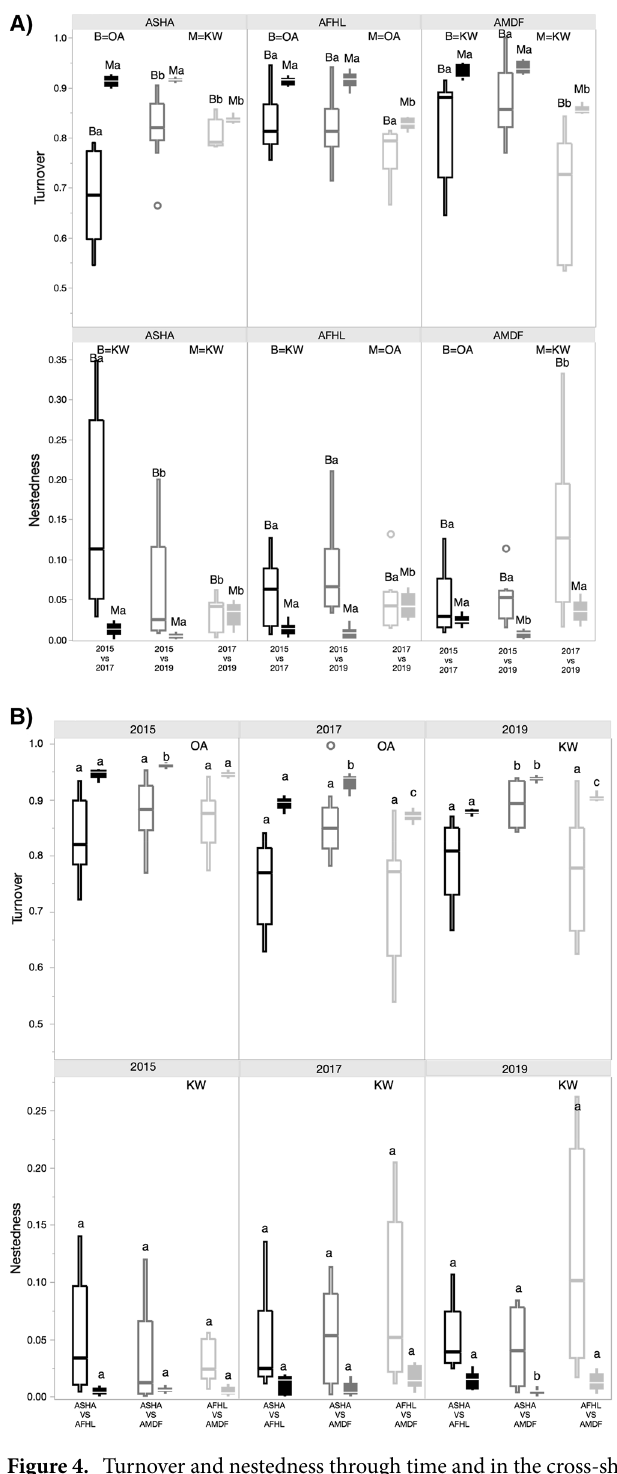
Figure 4. Turnover and nestedness through time and in the cross-shelf. ( A ) Comparisons between pairs of sampling times within the same reef in turnover [top graphs in ( A ) and nestedness [bottom graphs in ( A )] of the metabarcoding and barcoding fractions for the Jaccard dissimilarity metric using presence absence data. The arrangement of figure A is made to appreciate the distinctions in turnover and nestedness through time in each reef. ( B ) Turnover and nestedness between pair of reefs in the cross-shelf for each sampling date using the presence absence data for the Jaccard dissimilarity metric. Samples from the barcoding fraction (> 2000 µm) are delineated and from the metabarcoding fraction (106–2000 µm) filled. Lower case a and b letter marks the distinction of groups obtained from one-way ANOVA (OA) or from Kruskal–Wallis (KW). Reef names are abbreviated as: ASHA Abu Shoosha, ASHF Abu Shootaf, AFHL Al Fahal, and AMDF Abu